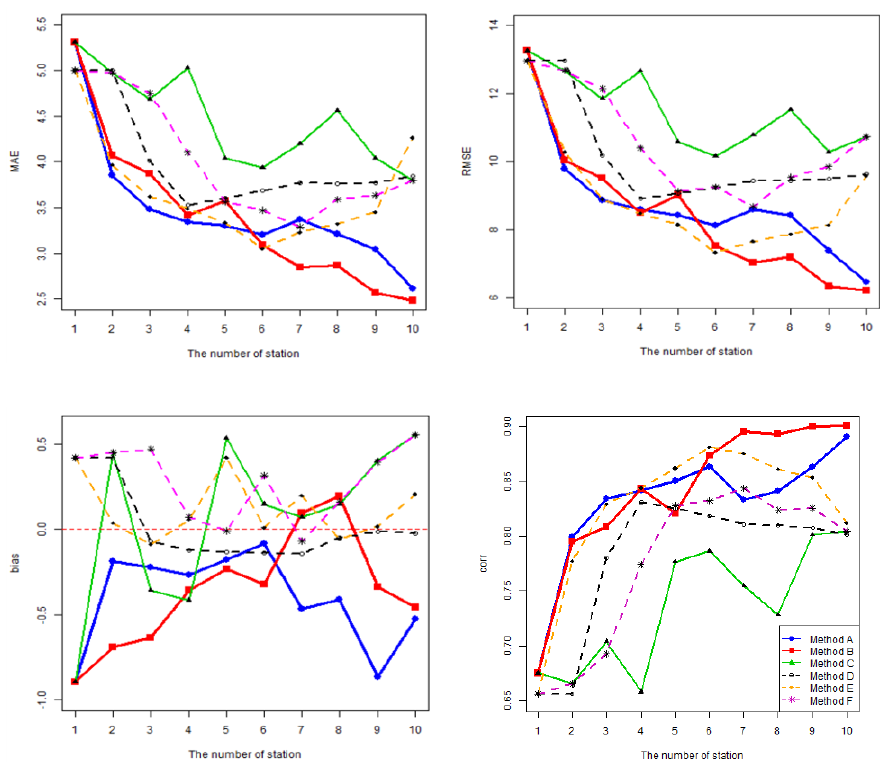
Figure 5. Result of MAE, RMSE, bias, and correlation coefficient (Corr) variation according to the numbers of stations for the rain gauge network calculated by different methods.